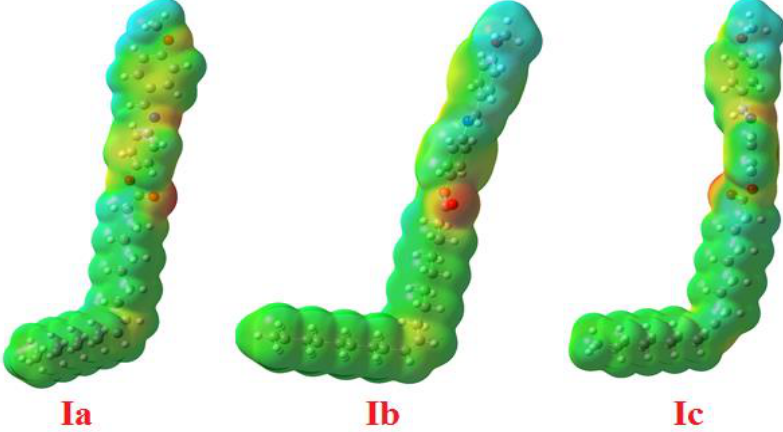
Figure 16. Molecular electrostatic potentials (MEP) for all investigated isomers, Ia – c .